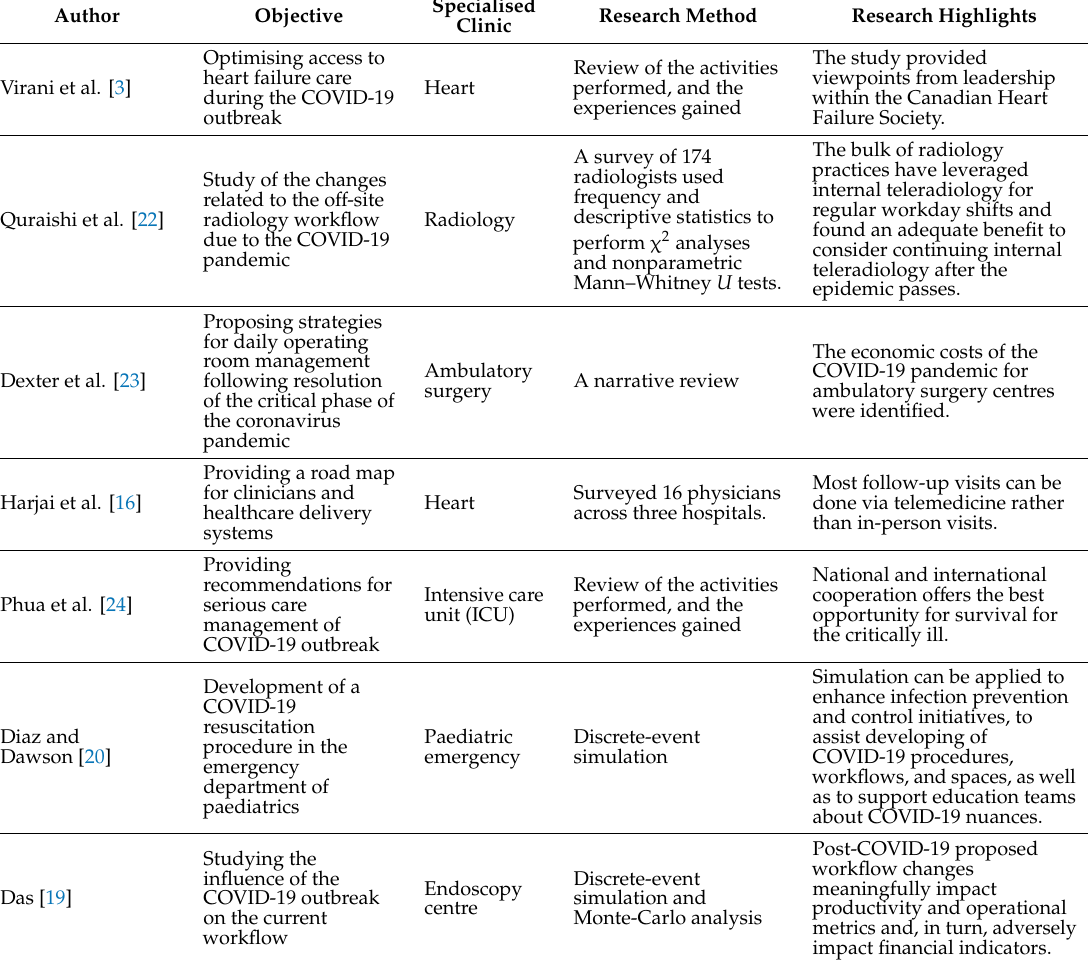
Table 1. Recent research regarding changes in patient workflow during the COVID-19